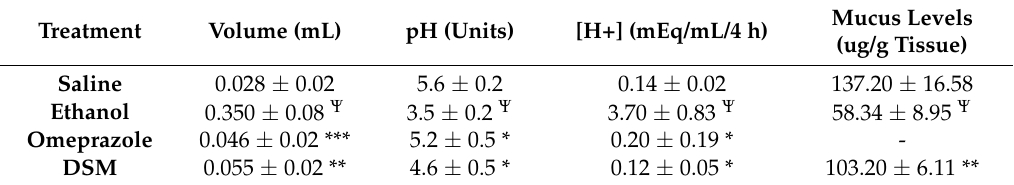
Table 1. DSM supplementation (10 8 CFU/g.bw/day for 3 days) on mucus levels and gastric acid secretion in